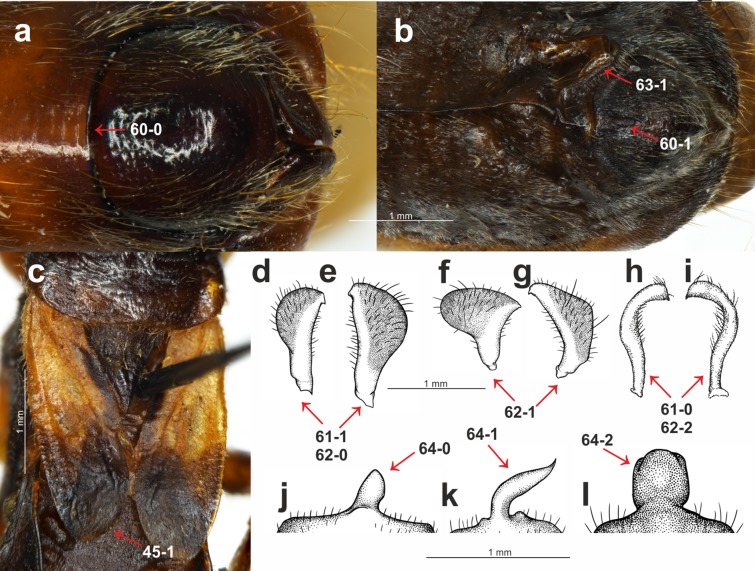
Morphological characters.(A) S. pedestris
Horváth, 1909, male pygophore; (B) Peirates strepitans Rambur, 1839, additional process on VII abdominal sternite of male and pygophore; (C) S. dimidiata Horváth, 1911, reduced hemelytron; (D) S. dimidiata Horváth, 1911, right paramere; (E) S. dimidiata Horváth, 1911, left paramere; (F) S. setosa
Chłond, 2018, right paramere; (G) S. setosa
Chłond, 2018, left paramere; (H) Platymeris rhadamanthus Gerstaecker, 1873, right paramere; (I) Platymeris rhadamanthus Gerstaecker, 1873, left paramere; (J) S. dimidiata Horváth, 1911, median process of pygophore; (K) S. setosa
Chłond, 2018, median process of pygophore; (L) S. nigra
Cai & Tomokuni, 2004, median process of pygophore.